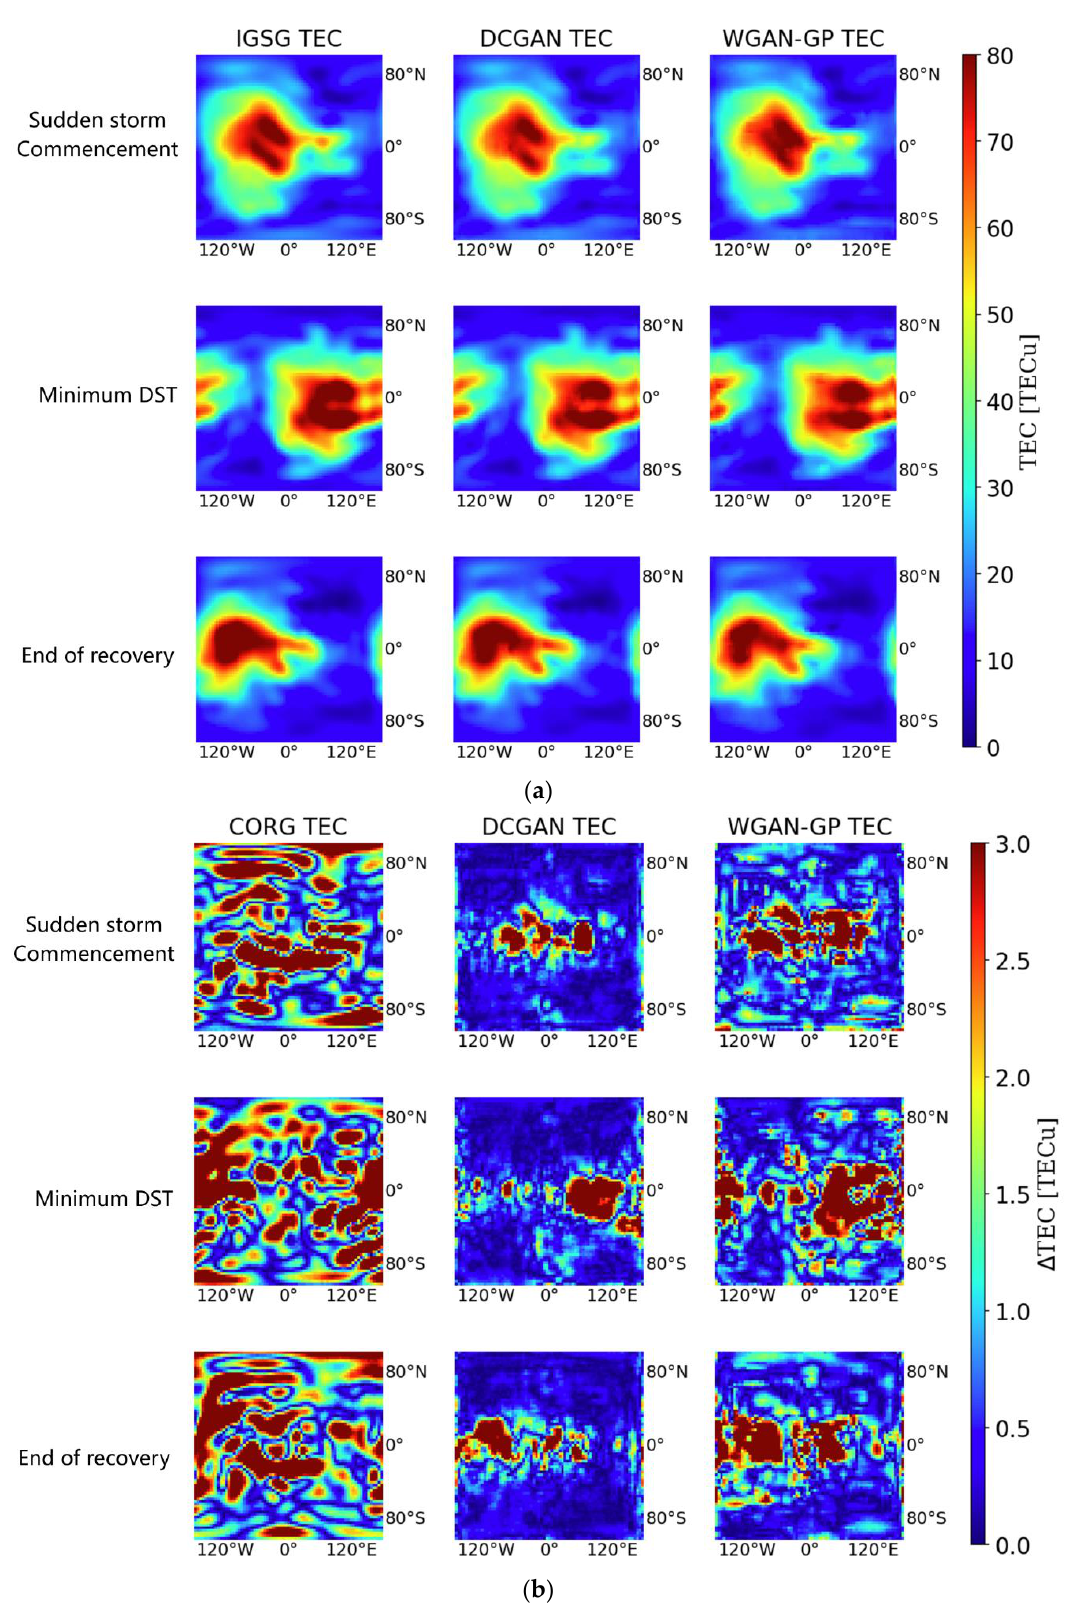
Figure 8. The ionospheric TEC ( a ) and the ionospheric TEC difference ( b ) for the geomagnetic storm on 18 February 2014. The sudden storm commencement, minimum DST , and end of recovery indicate three time points for the geomagnetic storm, as described above.